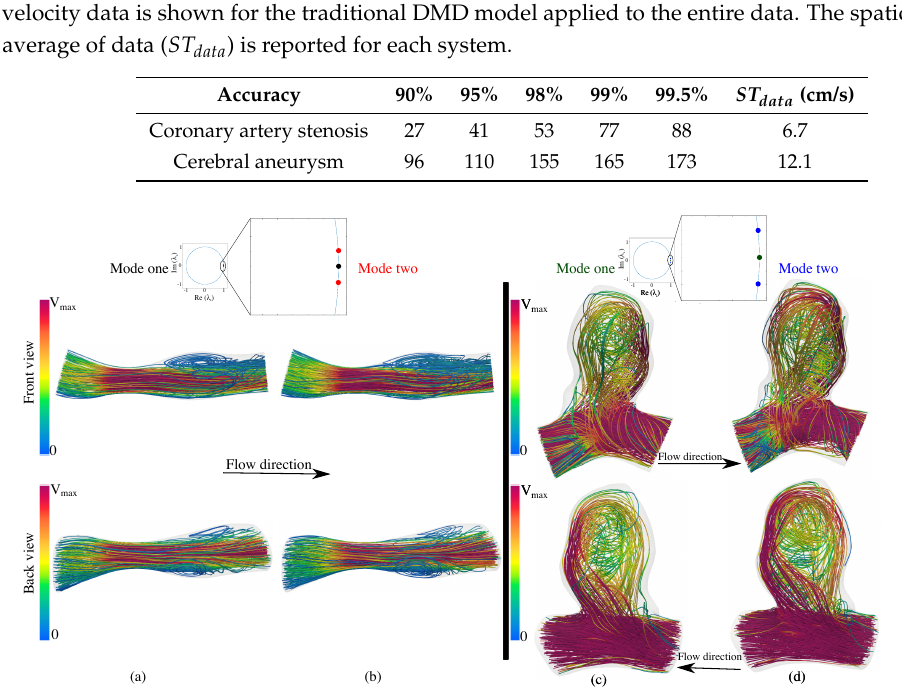
Figure 4. Two representative velocity DMD modes are shown for the original DMD method applied on the entire cardiac cycle. The location of discrete eigenvalues in the unit circle corresponding to the selected DMD modes are shown. Velocity streamlines are shown and colored by their magnitude. ( a ) Real part of the DMD mode corresponding to the eigenvalue λ = 1, ( b ) real part of the DMD mode corresponding to the eigenvalue λ = 0.99 ± 0.05 i for the coronary artery stenosis and ( c ) real part of the DMD mode corresponding to the eigenvalue λ = 1, ( d ) real part of the DMD mode corresponding to the eigenvalue λ = 0.99 ± 0.10 i for the cerebral aneurysm model are